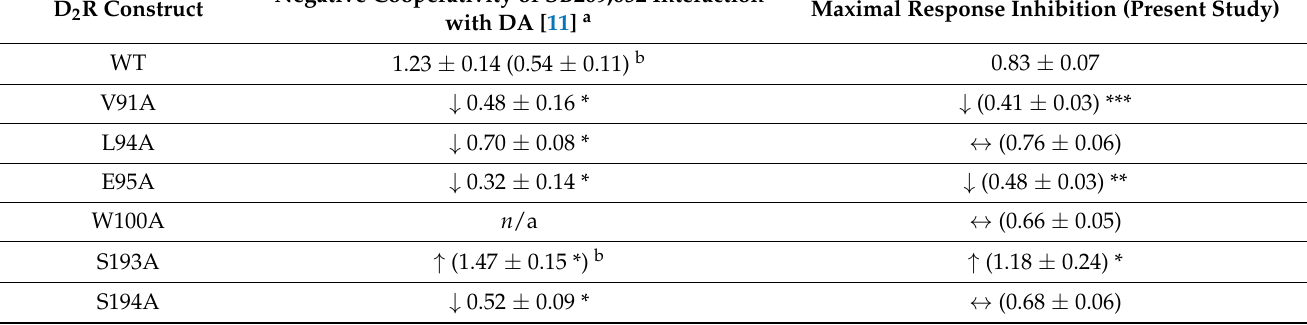
Table 3. Comparison between the effects of mutations of D 2 R OBS and SBP on SB269,652 negative cooperativity in a previous report [11] and maximal inhibition under pre-application conditions in the present